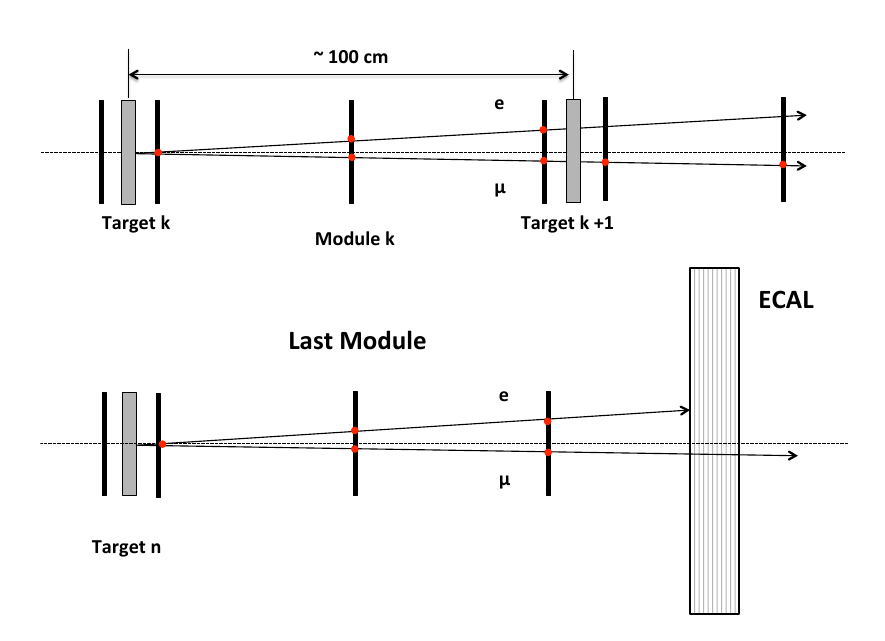
Figure 3. Scheme of a possible detector layout. (a) The detector is a modular system. Each module consists of a low- Z target (Be or C) and three silicon tracking stations within the distance of 50 cm. (b) To perform the µ -e discrimination in the case of small scattering angles (with both θ µ and θ e below 5 mrad) the detector is equipped with an electromagnetic calorimeter and a muon